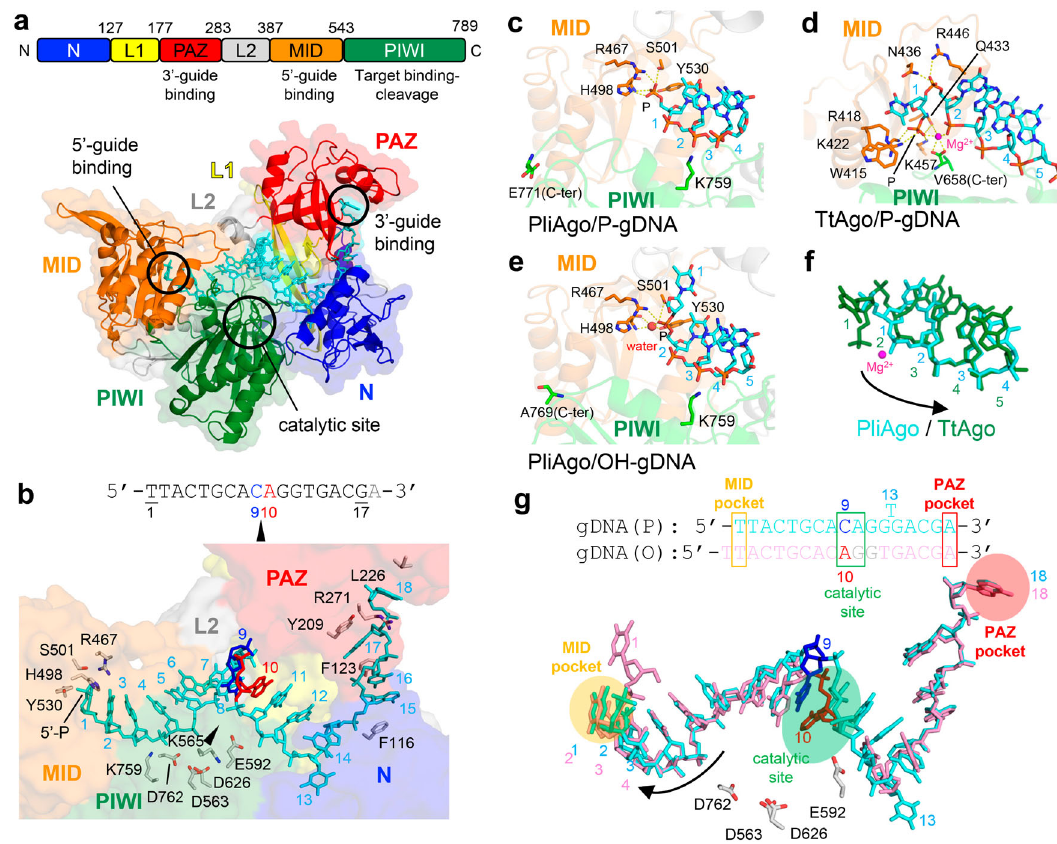
Fig. 2 | Structure ofPliAgo and its interactions with guide DNA. a The structure ofthePliAgoandP-gDNAcomplex.( Top )TheprimarystructureofPliAgowithamino acid numbering. Domains and their functions are colored and labeled. ( Bottom ) Overall structure of the PliAgo-P-gDNA complex. PliAgo and DNA are depicted as ribbon and stick models, respectively, with partially transparent surfaces. Domains are colored as in the top panel and labeled. b The PliAgo and P-gDNA interactions. ( Top ) The guide DNA sequence used for complex crystallization. Nucleotides that de fi ne the site of target RNA cleavage are colored. ( Bottom ) A magni fi ed view of the PliAgo-P-gDNA interactions. PliAgo is depicted as a partially transparent surface. DNA nucleotides and amino acid residues responsible for guide positioning are shown as stick models and labeled. The catalytic site is indicated as a black triangle. The view is the same as a . c – e The guide 5 ’ -end binding in the PliAgo-P-gDNA